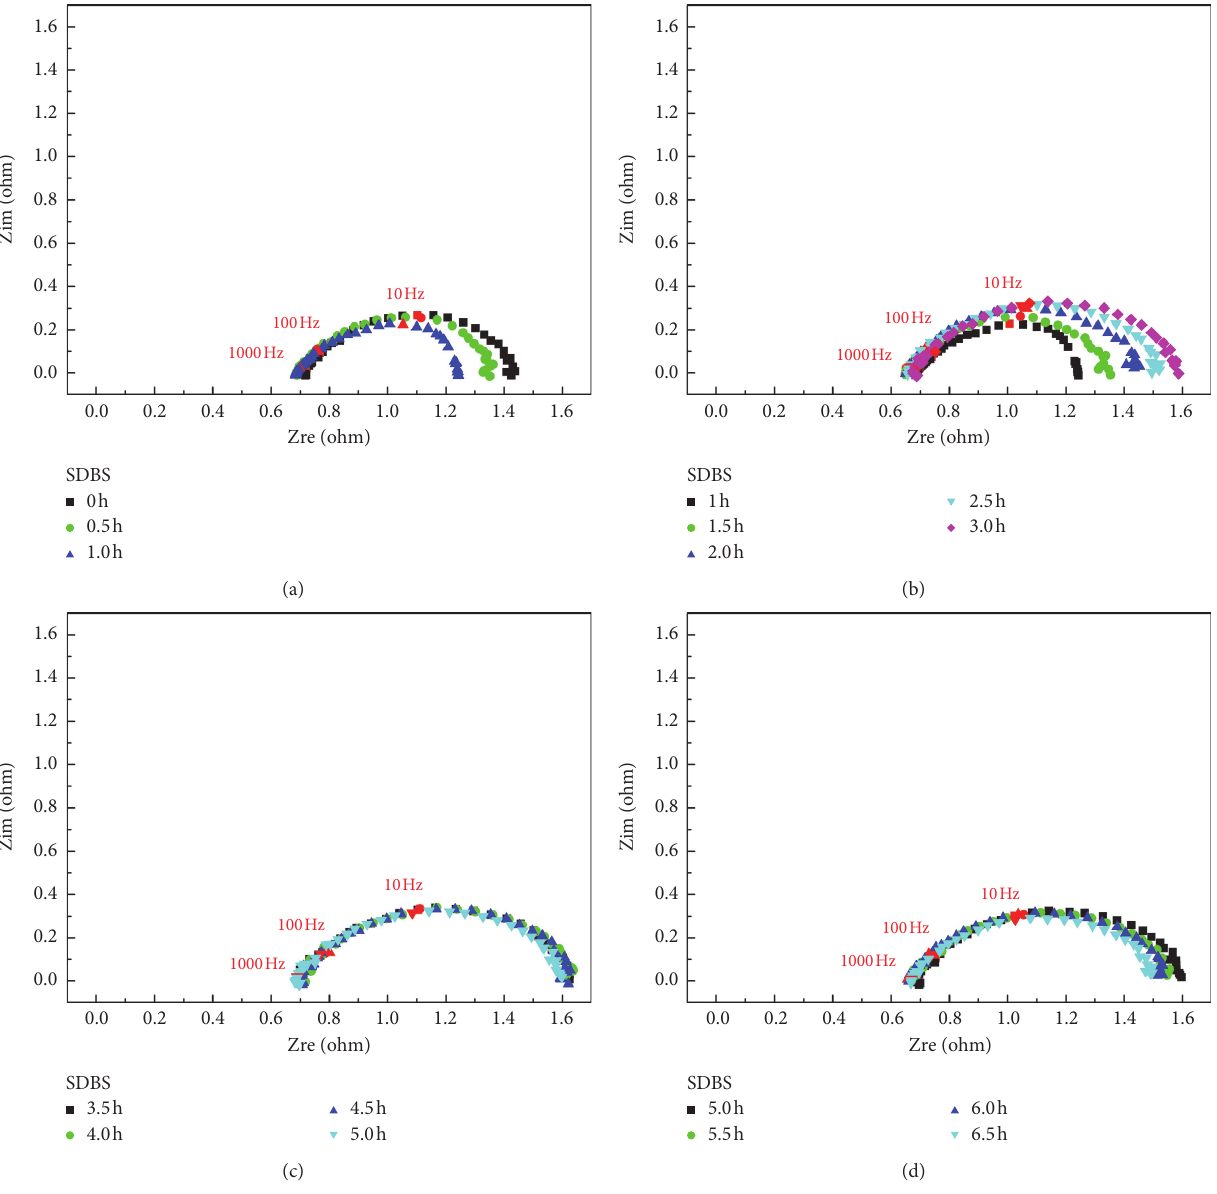
Figure 7: Nyquist diagrams at different times under the condition of adding SDBS: (a) 0–3.0 h. (b) 3.0h–9.0h. (c) 9.0h–11.0 h. (d) 11.5h–14.0